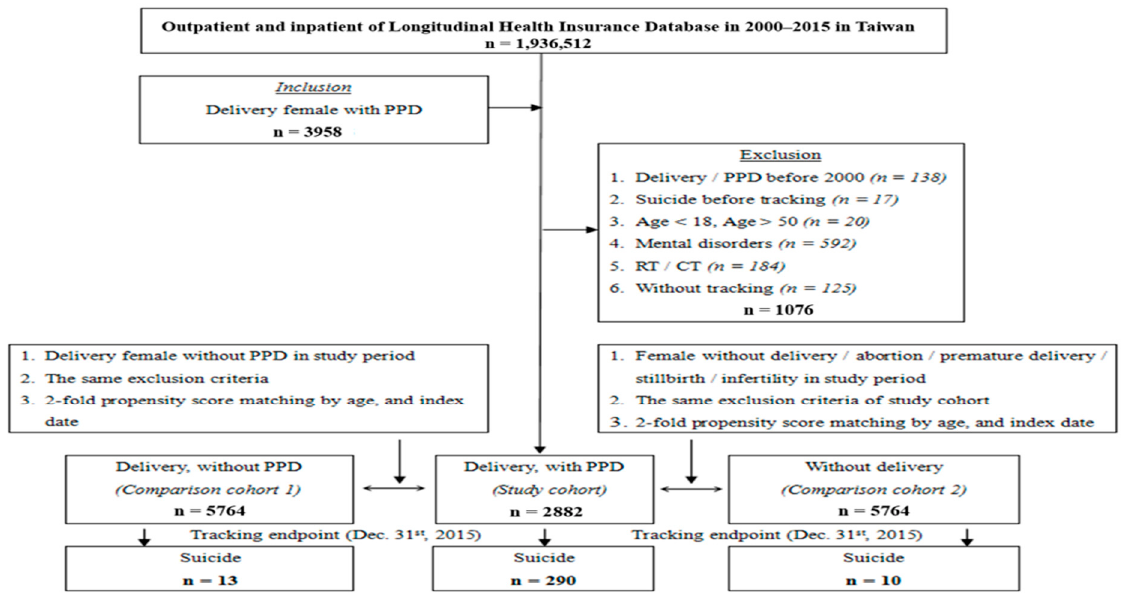
Figure 1. The flowchart of study sample selection. Abbreviations: PPD, postpartum depression; RT, radiotherapy; CT, chemotherapy.